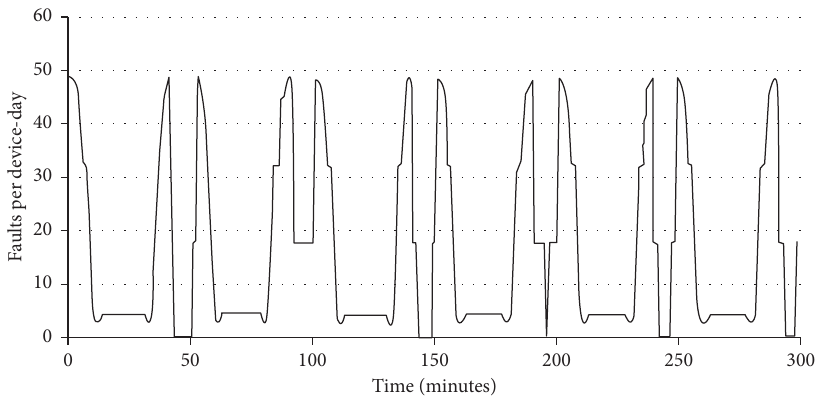
Figure 5: Expected fault rate of LEO (taken from